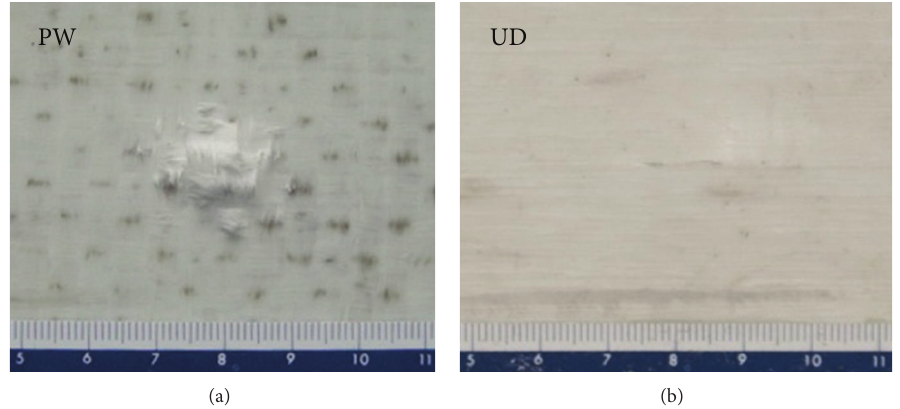
Figure 7: Rear face of the PW and UD samples subjected to 200 J impact